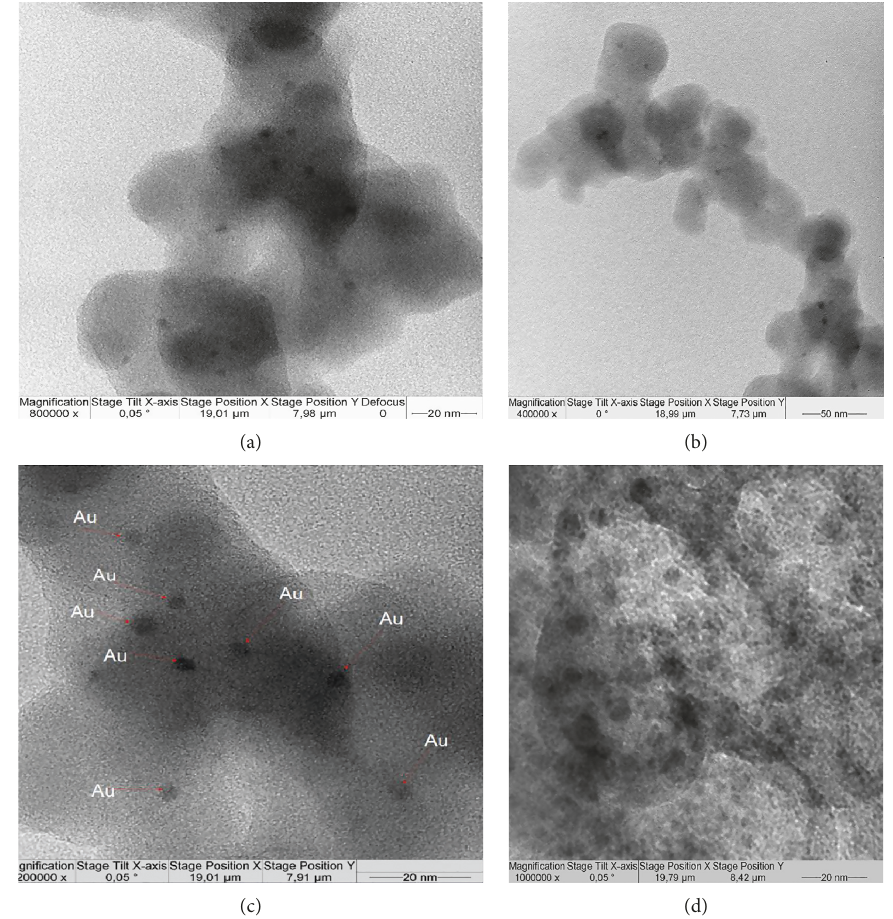
Figure 3: TEM images of the Si